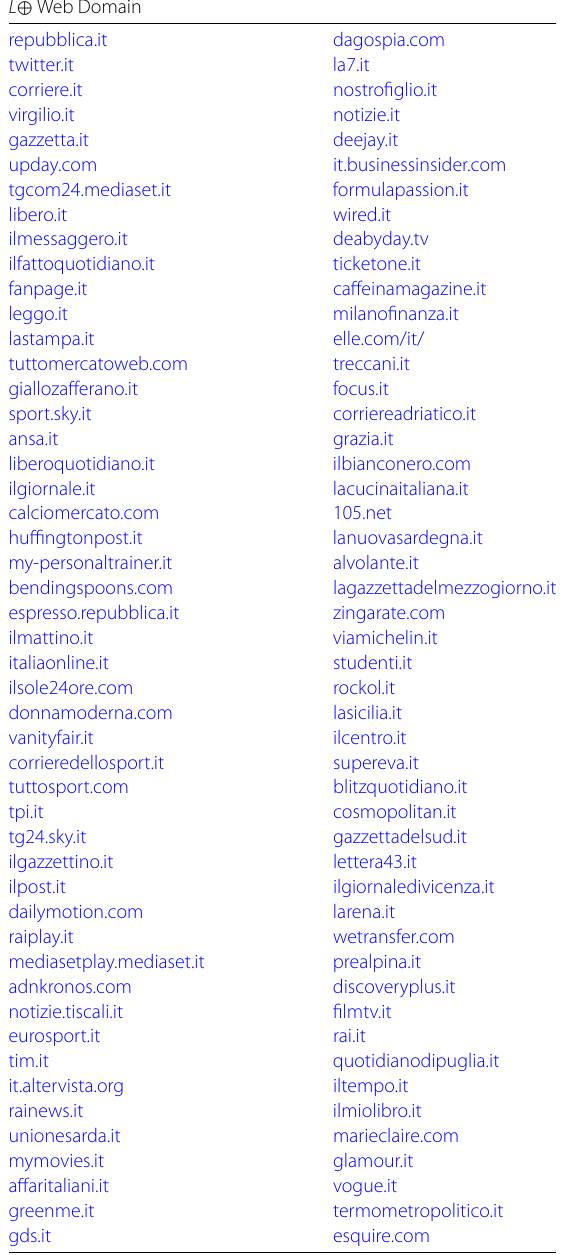
Table 4 List of the 100 most accessed media outlets according to “www.audiweb.it” in 2019, already filtered by sites in L (cid:3) . As an empirical counterpart of “unreliable” outlets, we consider these websites